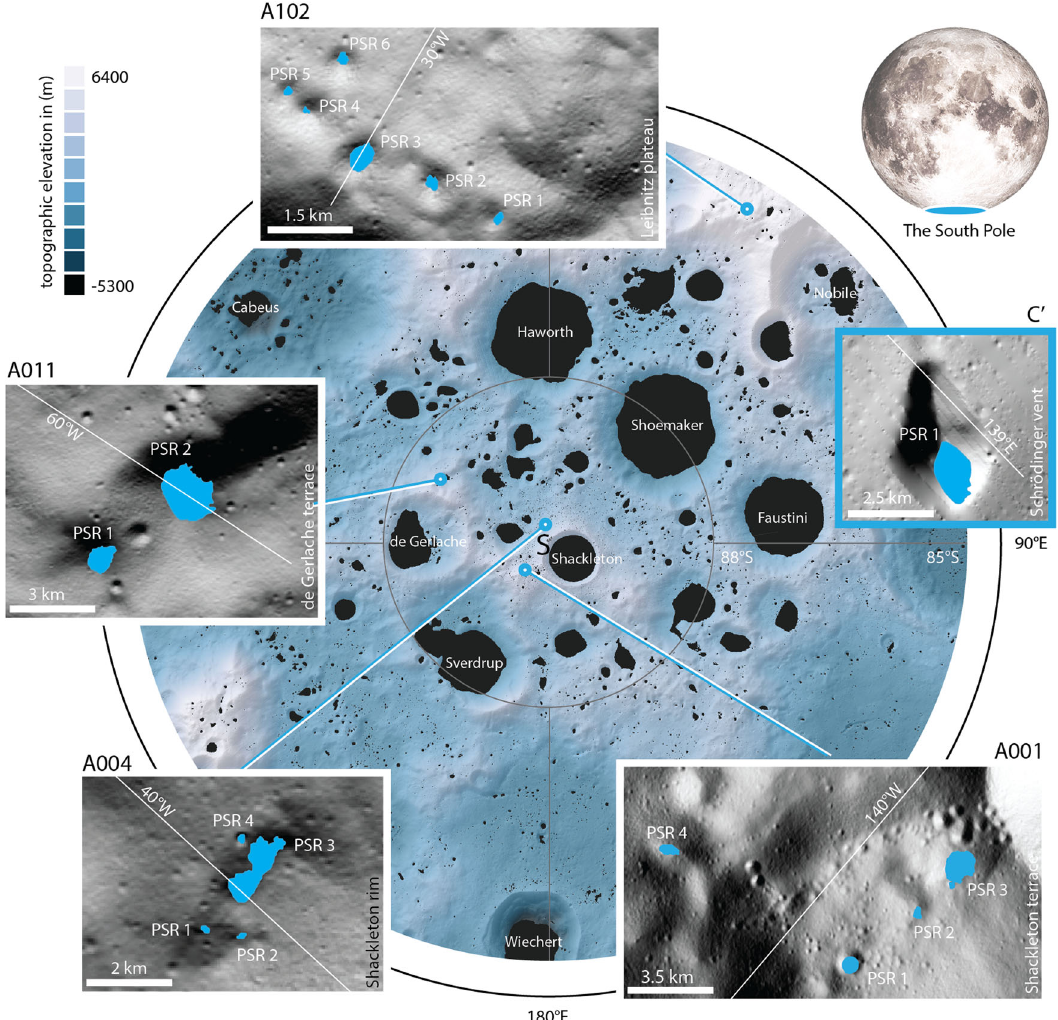
Fig. 2 Overview of the study areas. Topographic map of the lunar south pole, including large and small PSRs (permanently shadowed regions, black polygons); insets show the fi ve sites studied in this work (LOLA hillshade in the background). The insets use blue polygons to mark PSRs. All sites are either potential Artemis program candidates (A 2 ) or were Constellation program candidates (C ′ ). The site in Schrödinger Basin is distal and not indicated on the map (indicated by the blue box). PSR locations and extent taken from ref. 65 The boulder population of small lunar shadowed regions . We fi rst use the HORUS images to map boulders across all the target AoIs and PSRs. Examples of identi fi ed boulders are shown in Figs. 1, 3, and 4. Across the PSRs we identify a total of 20 intra- PSR boulders with average, minimum, and maximum diameters of 10, 3, and 19 m respectively. Not all PSRs host boulders and the spatial density of boulders is generally very low, around ~4 boulders/km 2 , on average; we only fi nd boulders in C ′ , A004 PSR 1, and A004 PSR 3. Boulders are located close to the edge of PSRs as well as towards their centers.